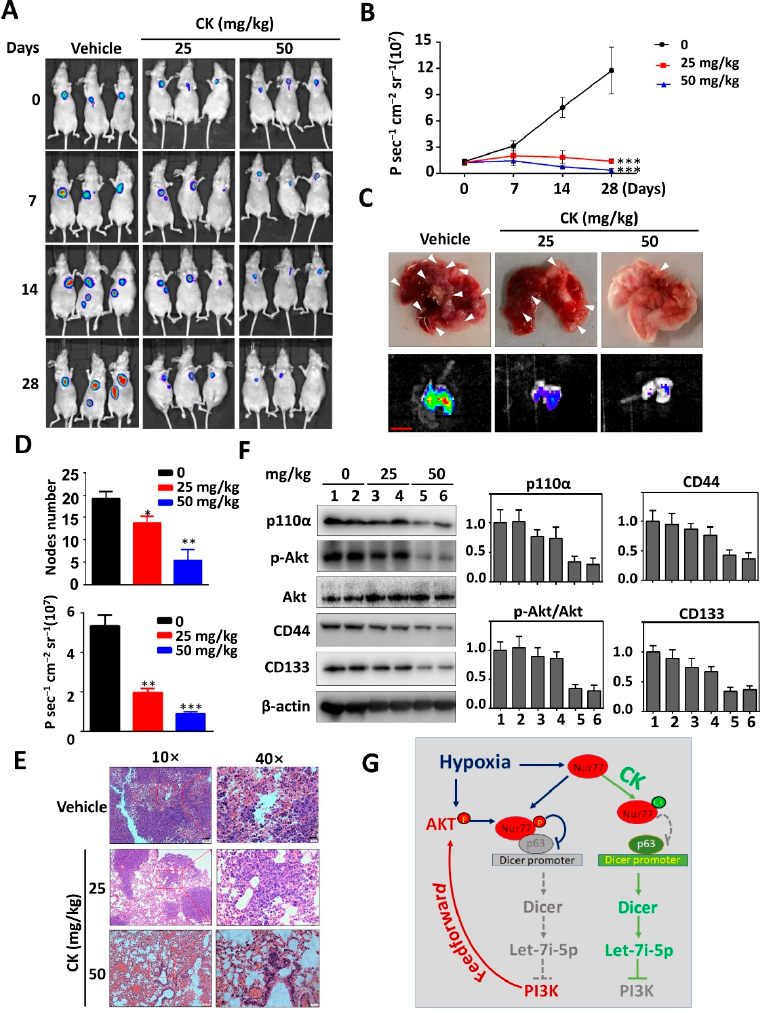
Figure 7. The anti-metastasis effect of CK in vivo. ( A , B ) BALB/c nude mice were injected with HCT116-luciferase cells through tail veins. After one month of CRC cell injections, the animals were treated with vehicle and CK (25 mg/kg and 50 mg/kg) once daily for 28 days. Bioluminescence im- ages ( A ) and intensities ( B ) were obtained from the IVIS Lumina system every week. ( C ) Repre- sentative metastatic nodule images in the lungs of mice after 28 days of treatment. Scale bar, 1 cm ( D ) The numbers of metastatic nodules were statistically analyzed. ( E ) Representative lung H&E staining image. Scale bars: 100 μ m in 10× and 20 μ m in 40×. ( F ) Metastatic nodules collected from each group were lysed and analyzed by Western blotting for the detection of p110 α , p-Akt, Akt, CD44, and CD133. ( G ) A proposed schematic mechanism. * p < 0.05, ** p < 0.01; *** p < 0.001 vs. respective control. Molecular weights for proteins are indicated in the full, uncropped, annotated Western blot images (Figure S9).